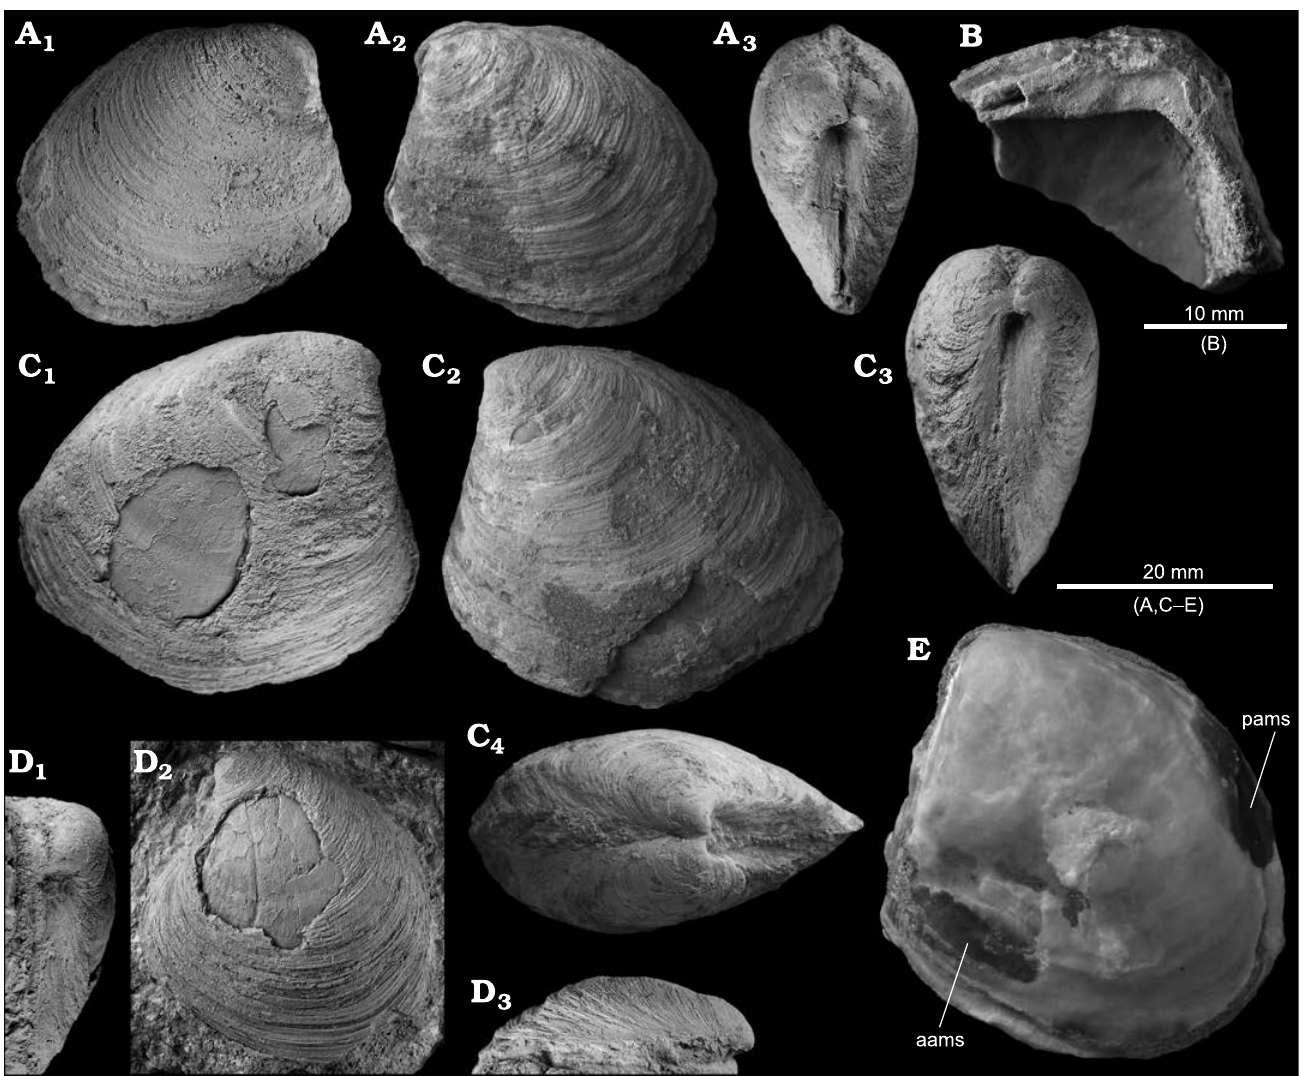
Fig. 7. The lucinid bivalve Megaxinus gorrospei sp. nov. from Upper Miocene seep deposits of the Amlang Formation in Pangasinan province, Luzon, Philippines. A . NIGSPAL-013, paratype, articulated, medium-sized specimen, view on RV (A 1 ), LV (A 2 ), and anterior margin (A 3 ). B . NIGSPAL-014, paratype, fragment of LV showing the hinge. C . NIGSPAL-015, holotype, large, articulated specimen, views on RV (C 1 ), LV (C 2 ), anterior margin (C 3 ), and dorsal margin (C 4 ). D . NRM Mo 192433, paratype, an isolated LV, views on anterior side (D 1 ), the outer shell (D 2 ), and the posterodorsal side (D 3 ). E . NIGSPAL-016, paratype, internal mold showing pallial line and adductor muscle scars (aams, anterior adductor muscle scar; pams, posterior adductor muscle